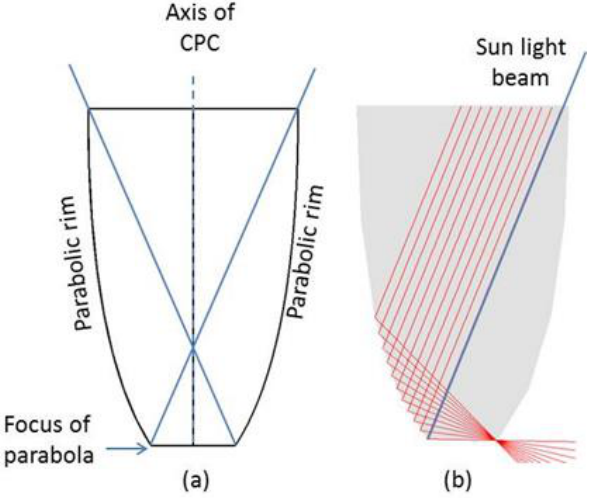
Figure 2. ( a ) A symmetrical CPC; and ( b ) ray tracing of the sunlight beam that is parallel to the axis of the parabolic rim.